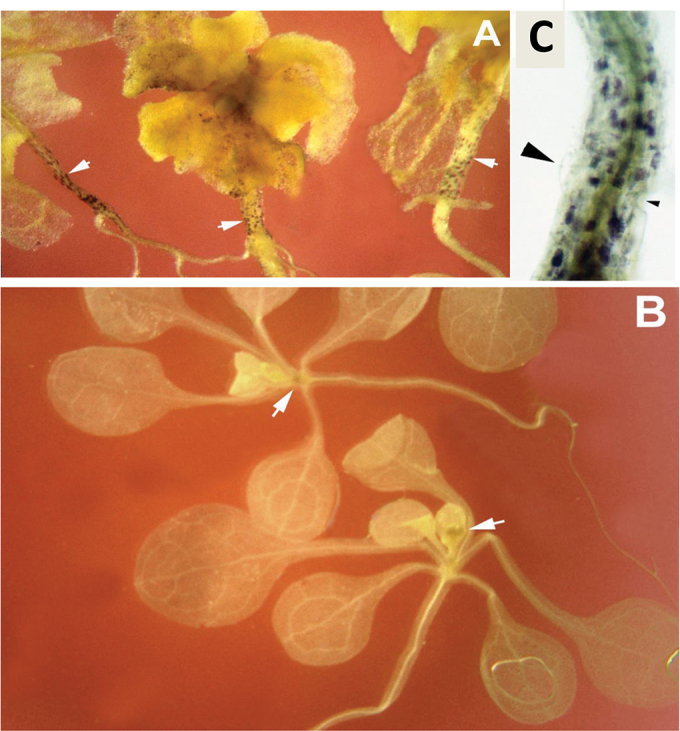
Ectopic localization of starch in hlq mutants. Staining for starch granules by KI shows ectopic localization of starch in the hypocotyl and leaves of hlq (A, white arrows), whereas there is no staining in the wild-type except at the meristem (B, white arrows). A close-up view of hlq hypocotyl (C) shows that the starch localization does not strictly correspond to hlq specific cell types—neither a bulged, radially expanded cell (large black arrowhead) nor a collapsed cell (small black arrowhead).